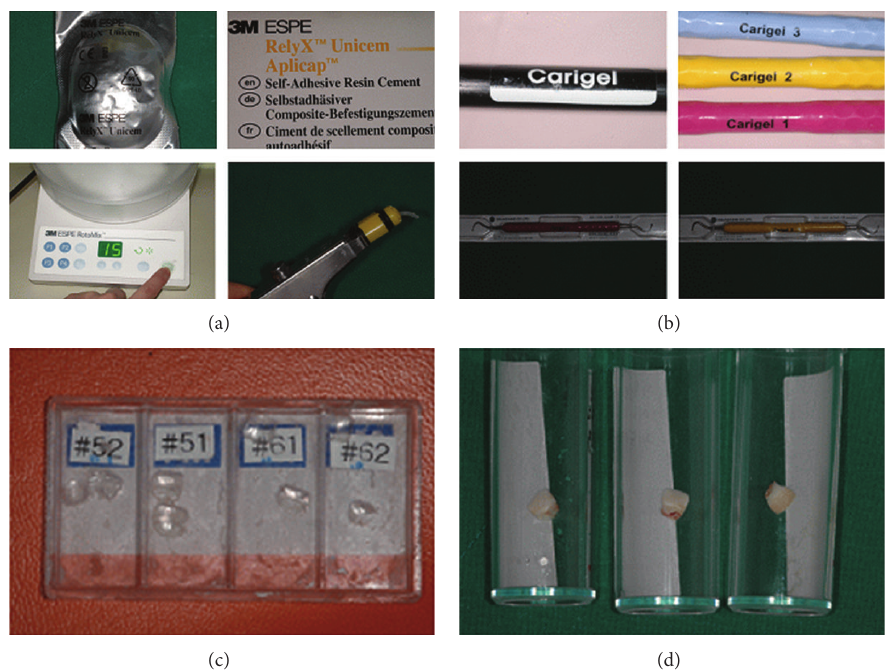
Figure 1: (a) RelyX Unicem. (b) Carigel. (c) Strip crown. (d) Primary tooth restored with RelyX Unicem. The patient used restoration until primary tooth is replaced by permanent